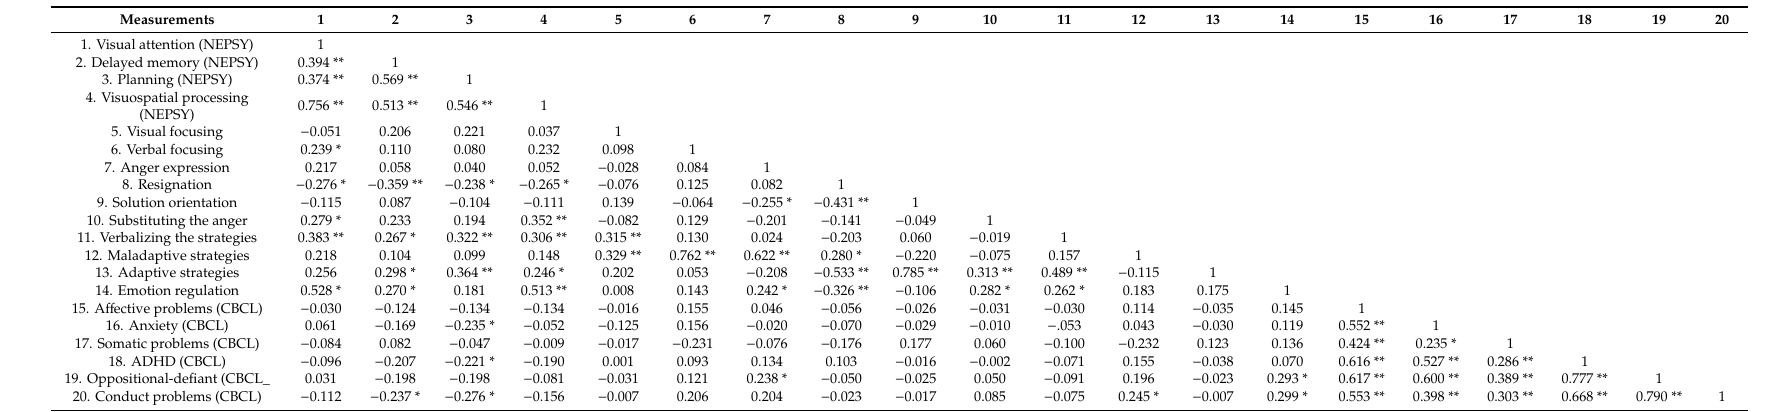
Table A1. Correlation coe ffi cients for the entire